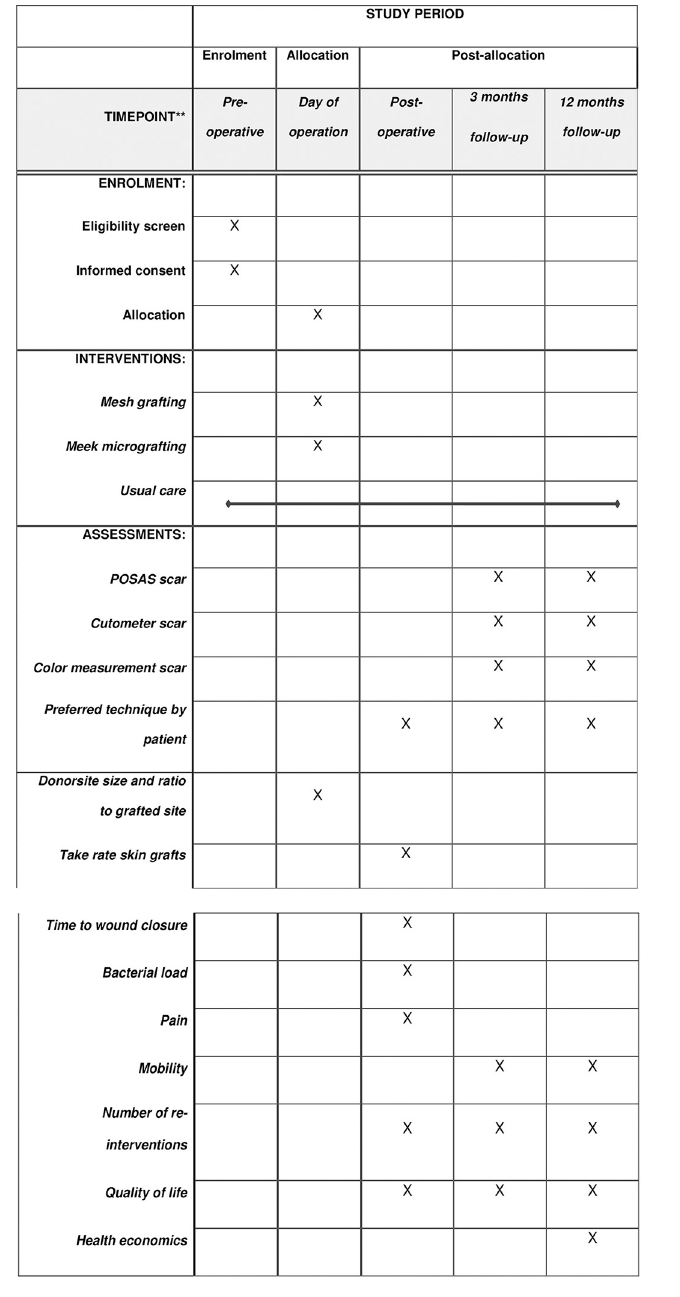
Fig 1. SPIRIT figure: Schedule of enrollments, interventions and assessments. gauze, a plisse´, which determines the expansion rate. After removal of the cork, the skin expan- sion is obtained by traction on all four sides of the plisse´. The firm supportive layer of the plisse´ is removed, leaving a single layered gauze with 196 separated graft squares. Finally, the plisse ´ with the graft squares is applied to the wound and fixated with staples. Similar to the mesh grafting technique, all pre-folded gauzes are covered with gauzes drenched in antimicrobial solutions based on wound cultures and topped with dry sterile gauzes and bandages (Fig 2).